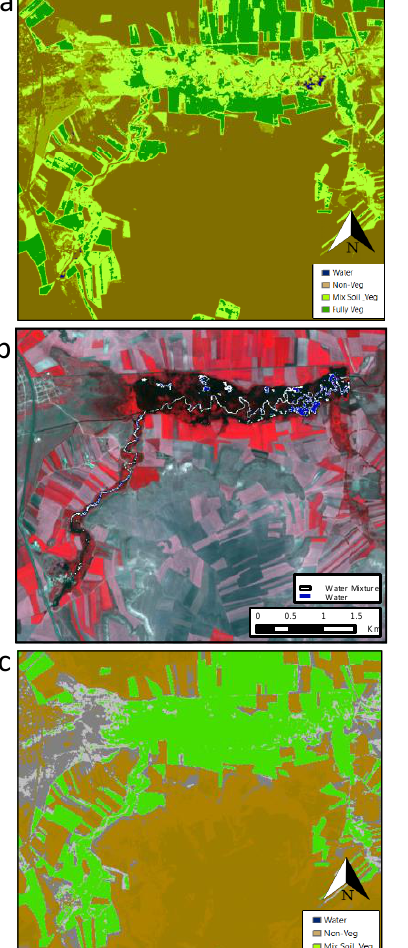
Figure 5. Object-based classification results within the a) Sentinel-2 frame; b) Clouds mislead; c) Sakarbasi wetland; d) Balikdami wetland; e) Kucukhasan wetland; f) Candir and Ortakoy